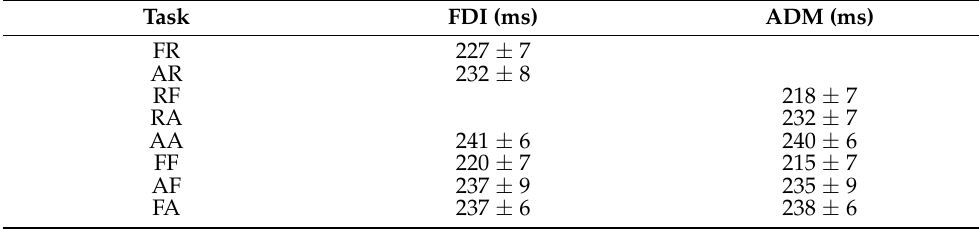
Table 2. RT of the tested